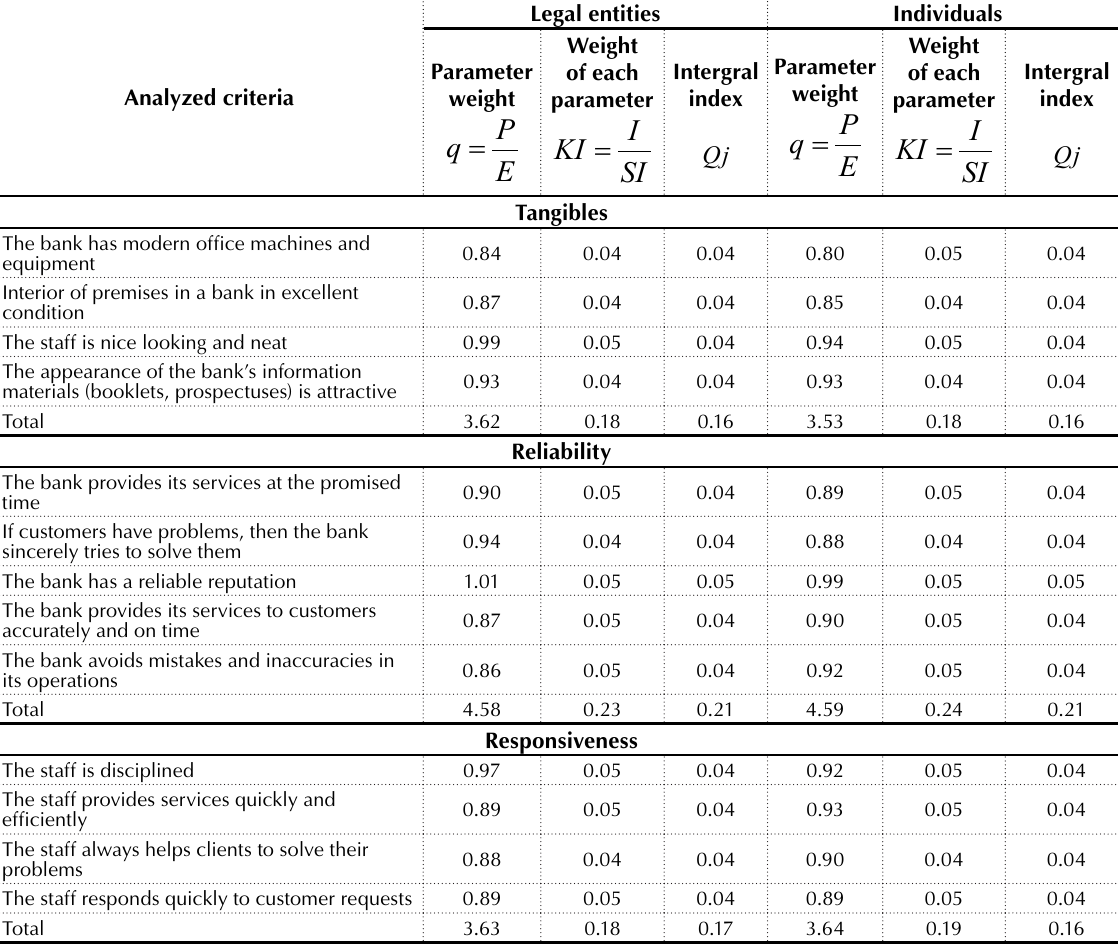
Table 1. Values of general and integral quality indicators